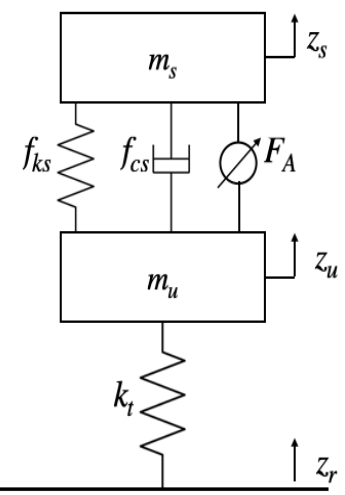
Figure 1. Quarter-Car Active Suspension